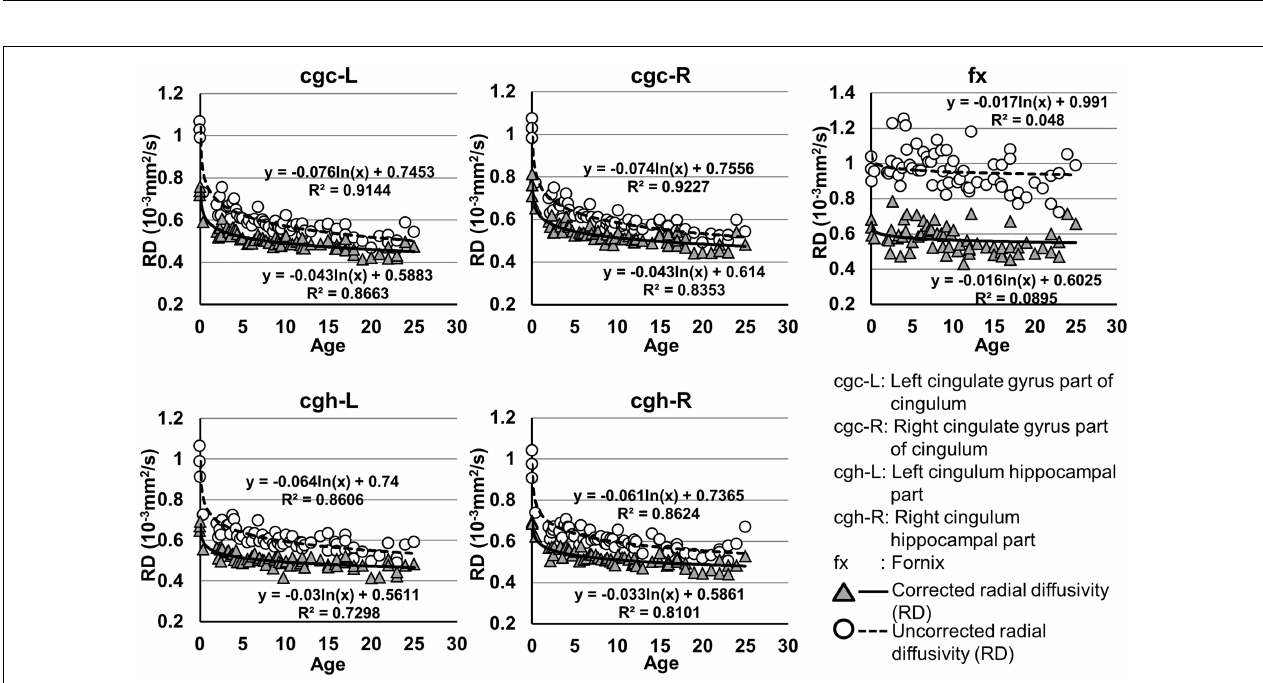
FIGURE 6 |Age-dependent changes of uncorrected and corrected radial diffusivity (RD) measurements of limbic tracts . R 2 and fitting equations are listed in each panel.